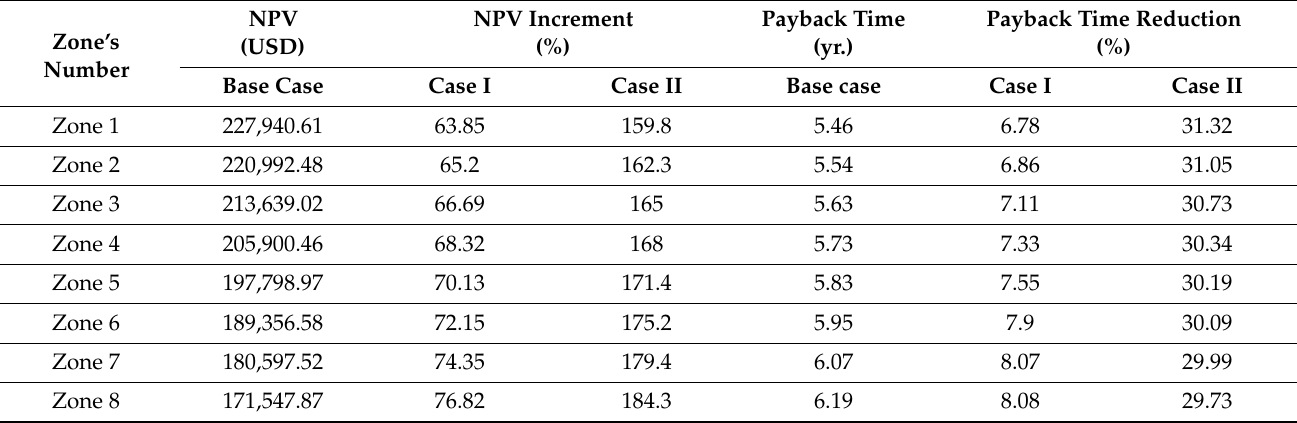
Table 11. Comparison of the results of three